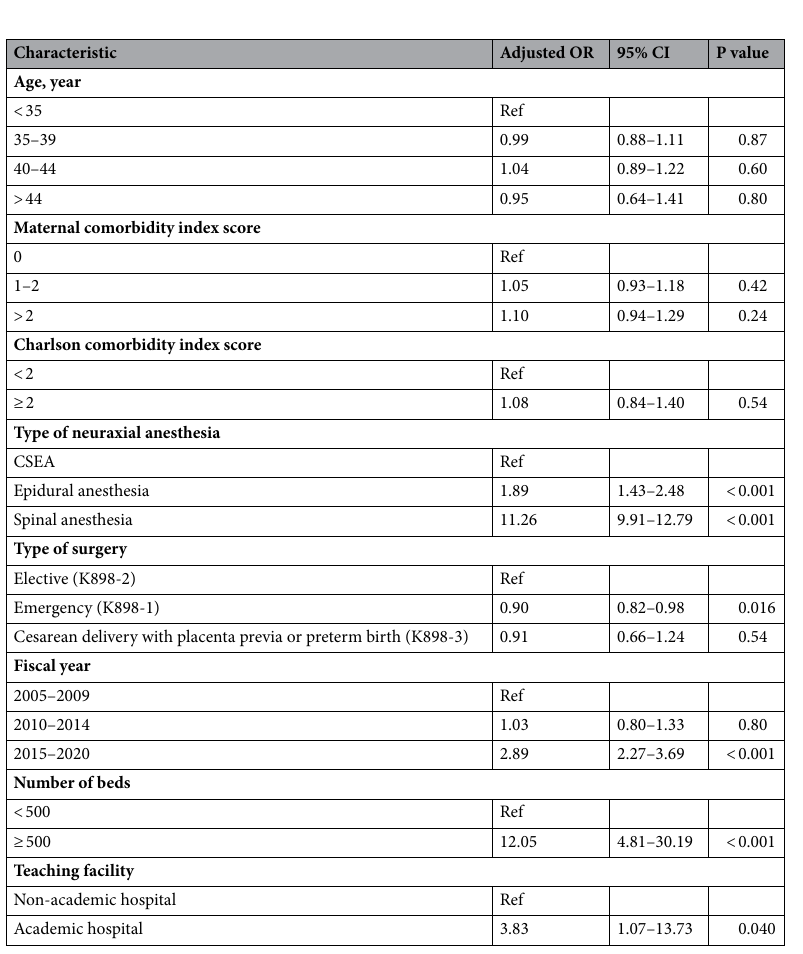
Figure 3. The annual rates of intrathecal morphine use in spinal anesthesia cases and type of surgery (overall, elective, and emergency) from 2005 to 2020.